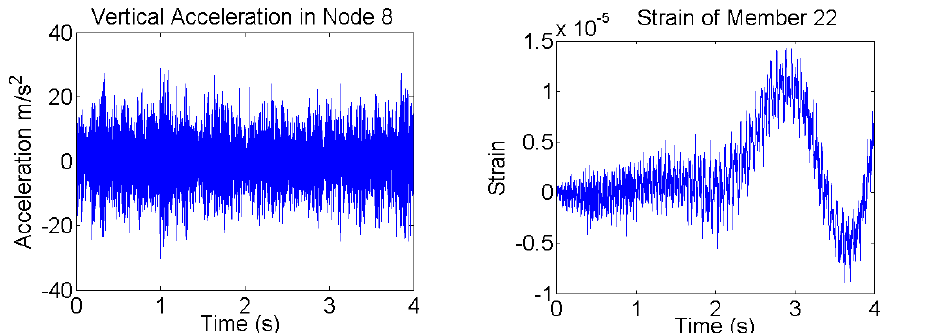
Figure 7. Simulated acceleration ( Left ) in vertical direction at Node “8” and strain ( Right ) in the member “22” when the forces shown in Figure 11 (dotted black) are applied to the structure simultaneously. Low frequencies (almost DC components) are seen in the strain